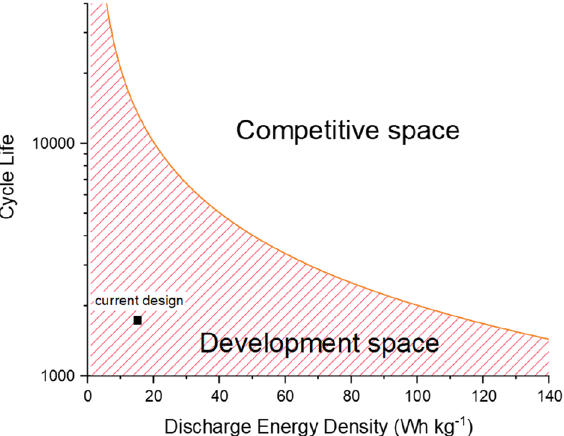
Figure 1. Competitive parameter space representing the CFEDs required to match Li-ion in CO 2 emissions, the line represents the 200 kWh CFED, with the space below being the development space, and the space above, where the design is environmentally competitive.